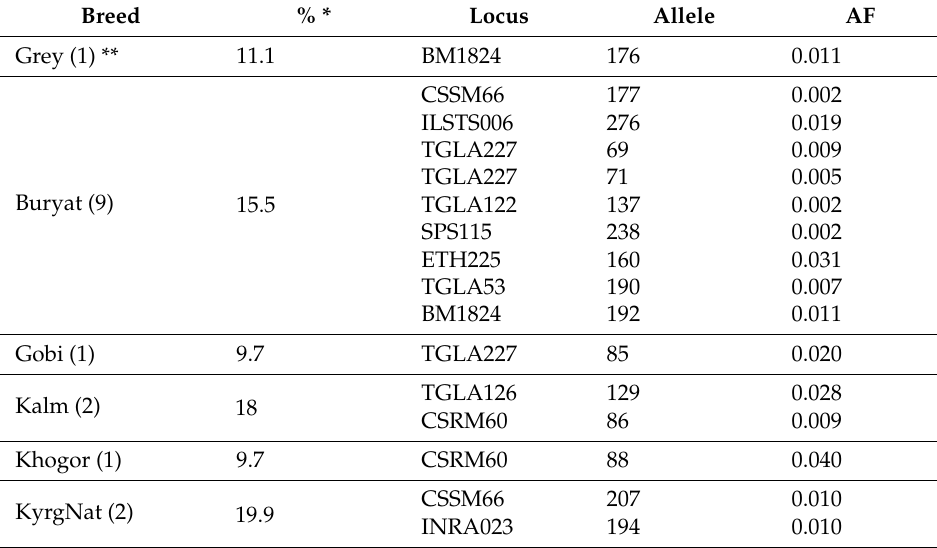
Table 3. Private breed-specific alleles by locus and